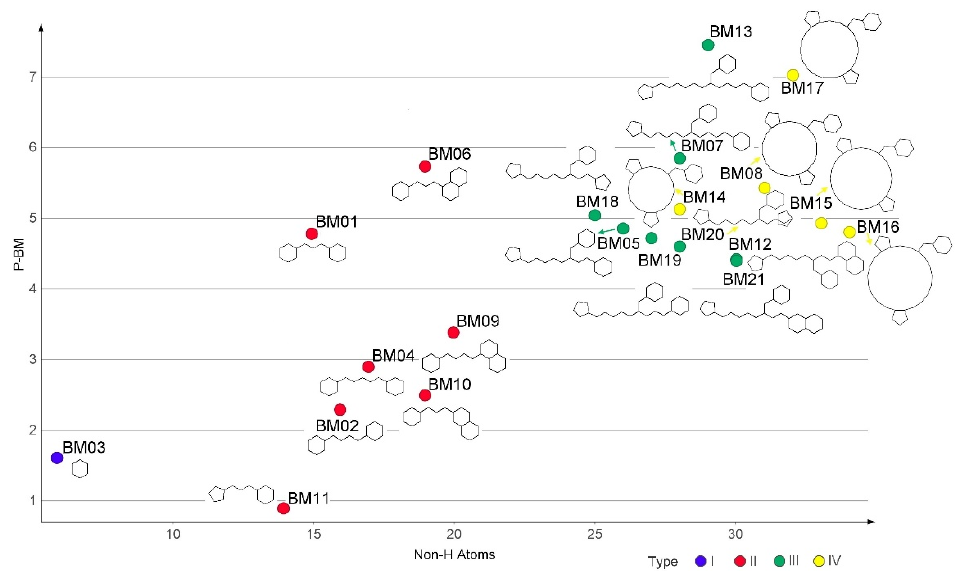
Figure 2. The structures of BM1-BM21 skeletons and the relation of their P-BM values depending on the number of carbon atoms and their types (I–IV).